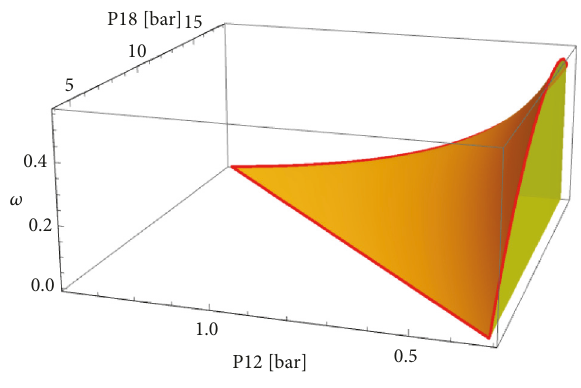
Figure 15: Entrainment ratio vs . primary pressure, 𝑃 18 , and back- pressure, 𝑃 12 , for fixed nozzle area ratio, (𝐴 𝑖 /𝐴 𝑡 ) = 17.3 , and secondary pressure, 𝑃 19 = 0.0628